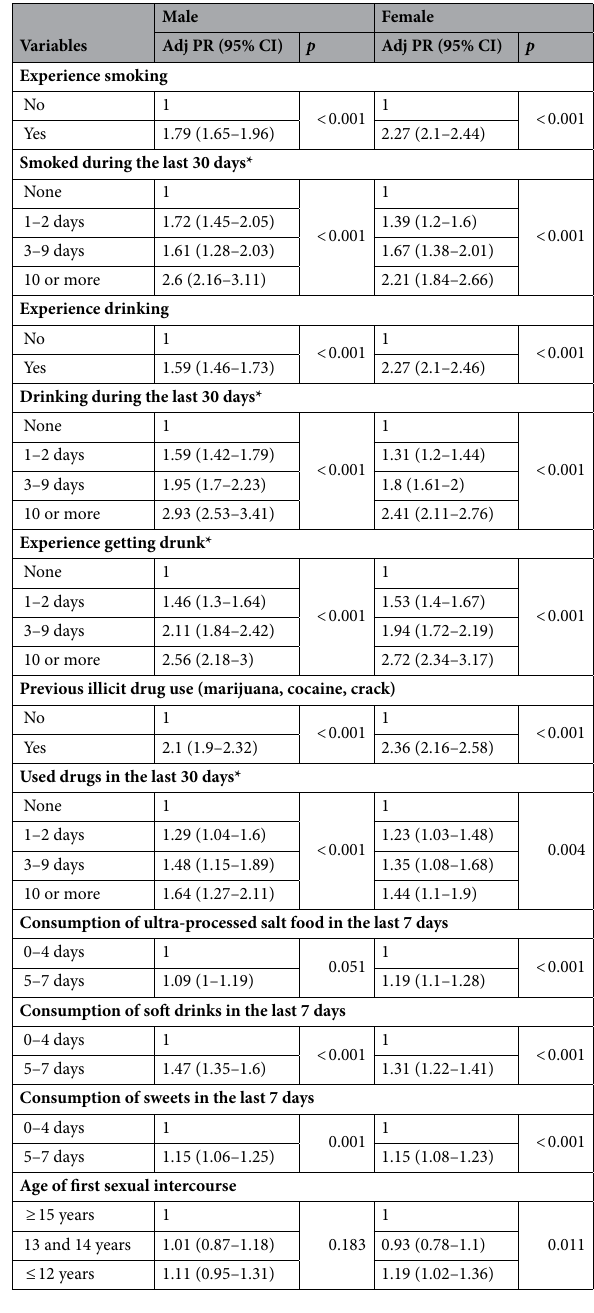
Table 3. Adjusted analysis between unhealthy life habits and laxative misuse and/or self-induced vomiting in Brazilian adolescent boys and girls (N = 102,072). The analysis was conducted using the Poisson regression model with robust variance. The effect measure is the PR with its respective 95% CI. The model was adjusted for confounding variables: region, school, age group, and mother’s schooling. Adj PR adjusted prevalence ratio, CI confidence interval. * Only where